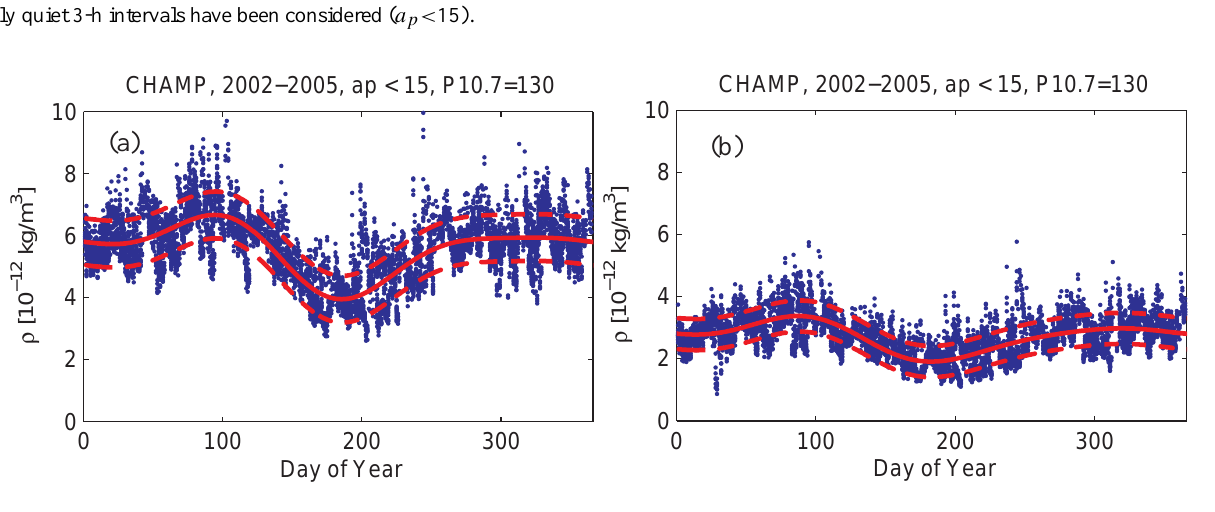
Fig. 8. Seasonal variation of the density in the day (a) and night (b) time sector. The same data as for Fig. 7 have been used. The solid red curves represent the fitted annual harmonics functions. Dashed lines mark the RMSE